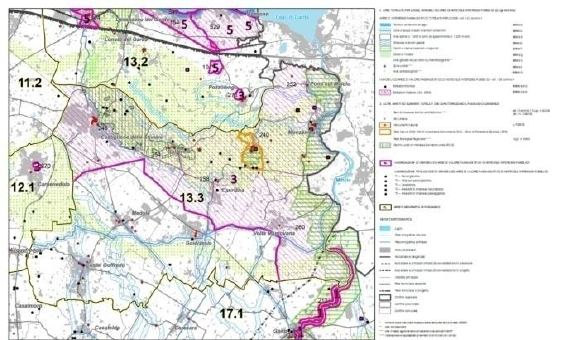
Figure 2. Lombardy PPR, review: detail of